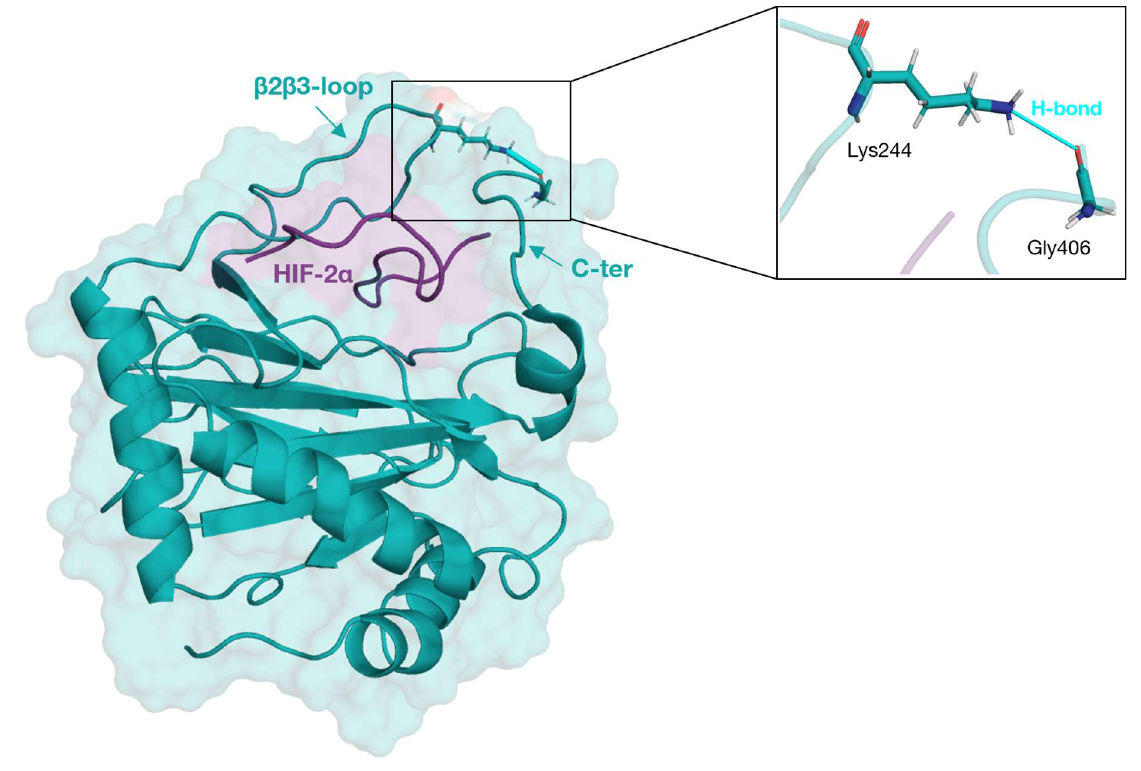
Figure 6. β2β3-loop and C-terminus H-bond interaction. PHD2 (teal) and HIF-2α (purple) are represented in cartoon style. Lys244 and Gly406 residues are represented by licorice and H-bonds (turquoise) by a stick. Table 2. Total cluster numbers of PHD2/HIF-1 α , PHD2/HIF-2 α , PHD2/HIF-2 α with Thr405-P (TPO), and PHD2/HIF-2 α with Thr405-P